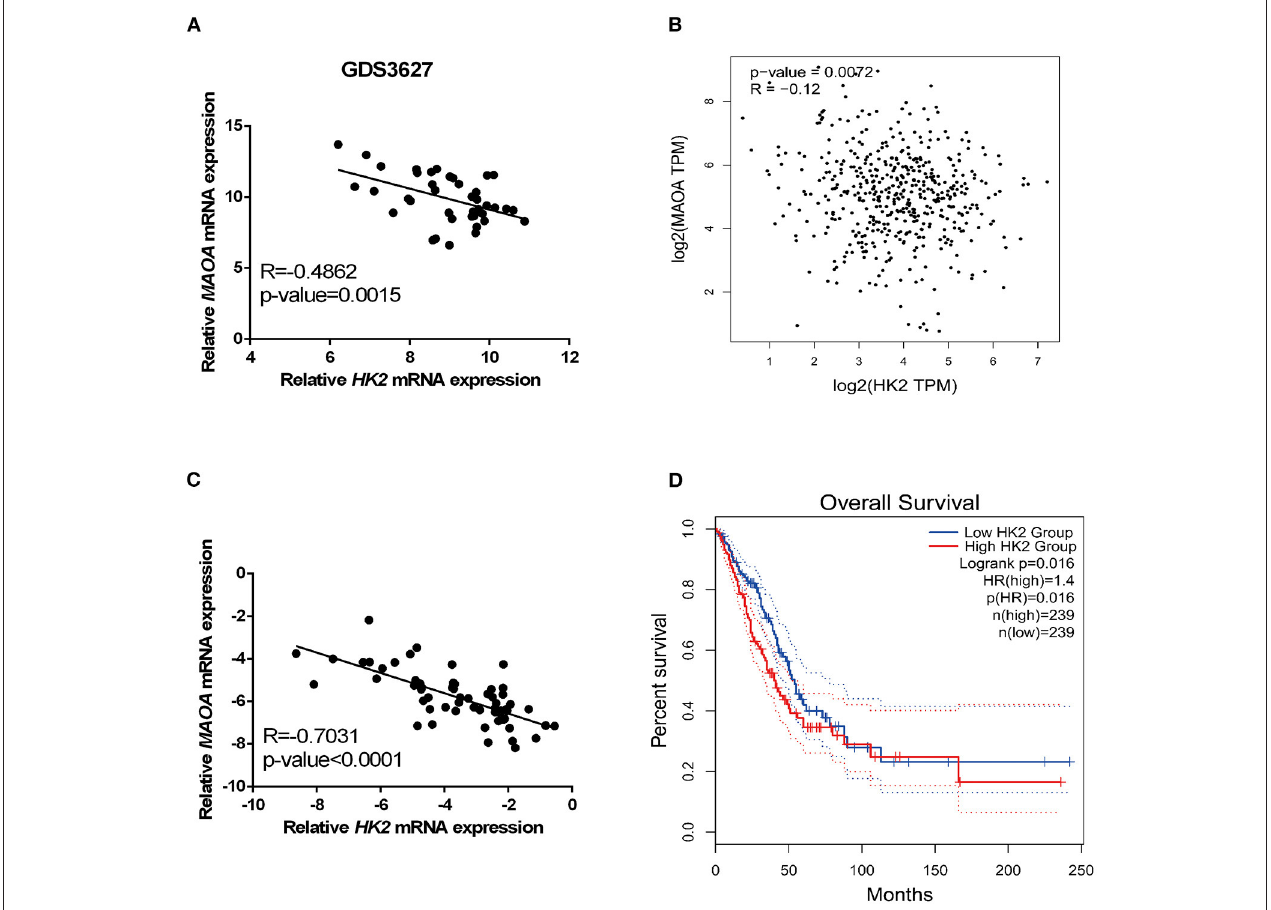
FIGURE 5 | HK2 correlates negatively with MAOA in LUAD. The correlation between HK2 and MAOA was analyzed in the GEO dataset (A) , GEPIA (B) , and our collected LUAD tumors (C) . The survival rate of patients with LUAD was analyzed in GEPIA according to the expression of HK2 (D) .